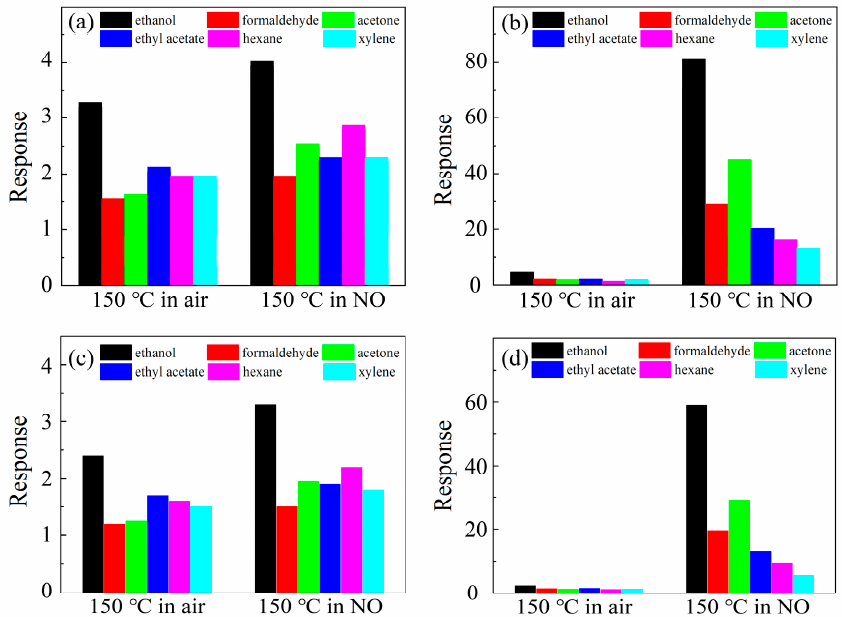
Figure 7. The response curves of SnO 2 and Pt-SnO 2 sensors to 10 ppm different VOCs with ( a , c ) or without ( b , d ) humidity (50% RH) in air and 1 ppm NO.